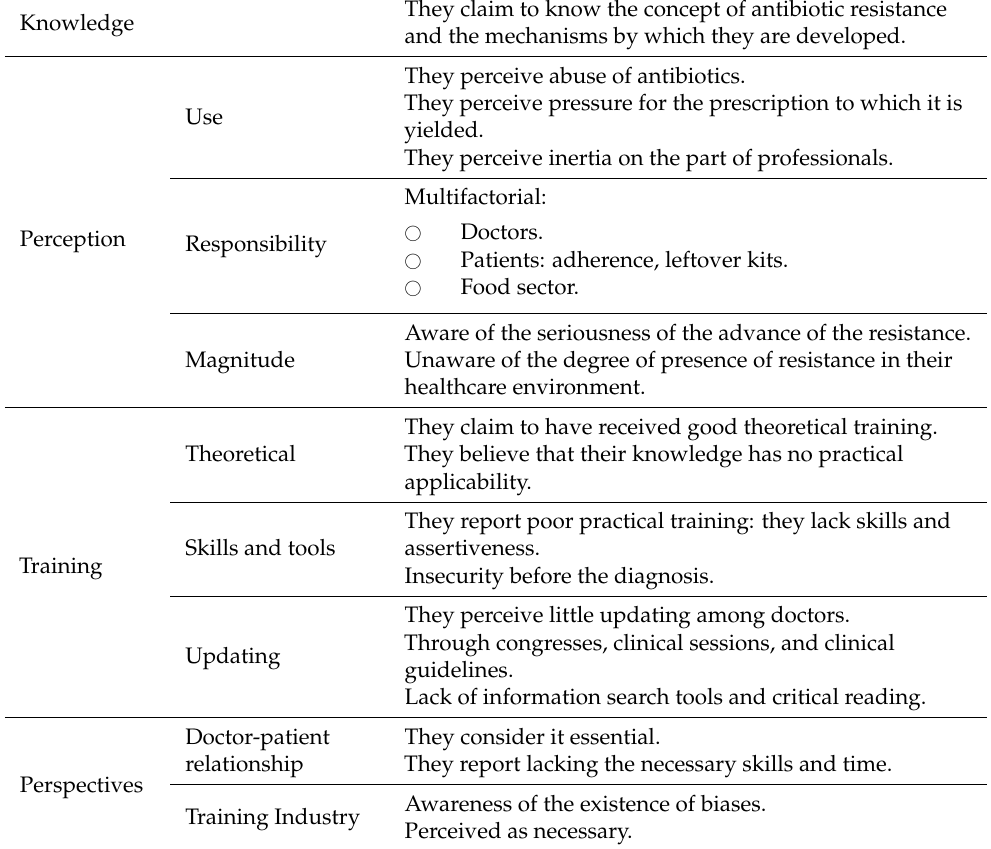
Table 2. Factors identified with respect to knowledge and attitudes regarding antibiotic use among medical